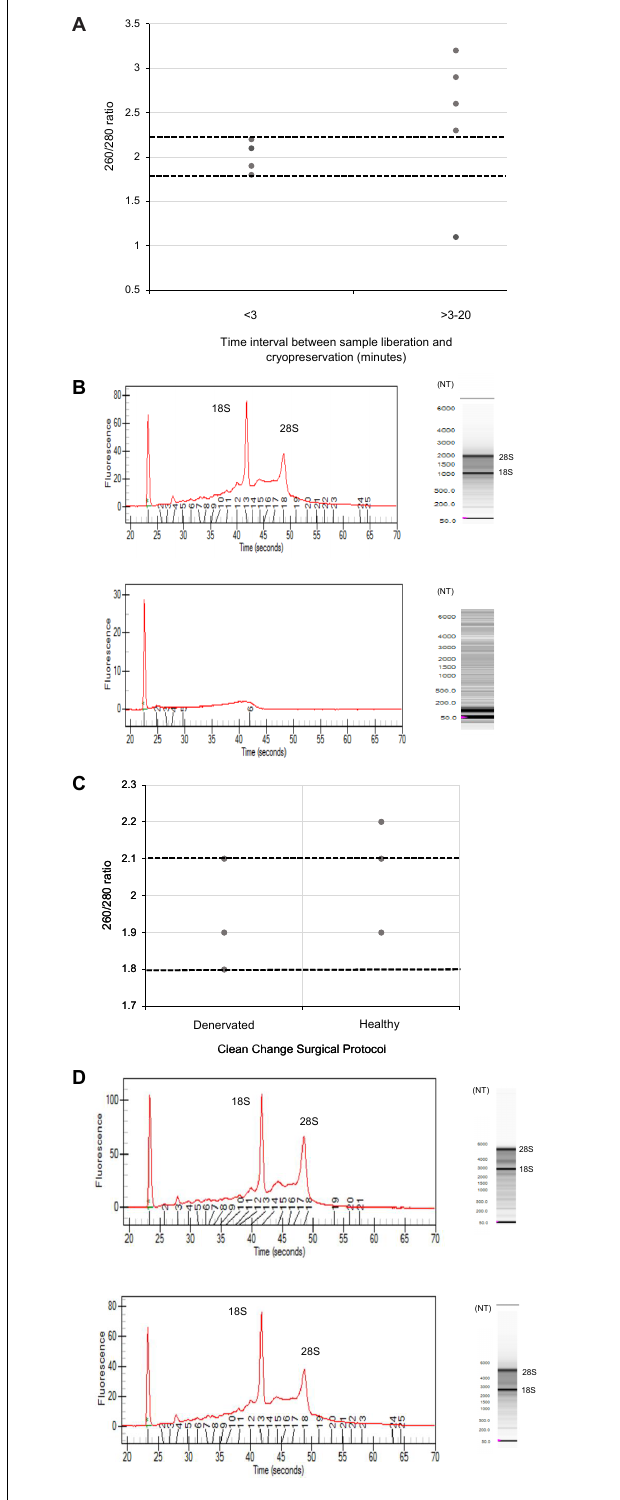
FIGURE 2 | The effect of time delays and surgical antiseptic reagents on the quality of RNA isolated from human nerve tissue. (A) A scatter plot to